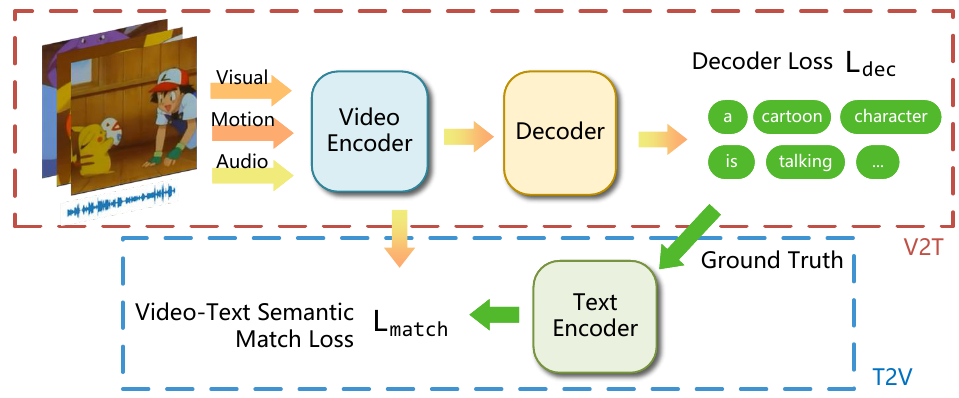
Figure 1. Use of two flows in our method. Traditional video-to-text (V2T) flow: the video encoder encodes the multimodal feature, and the decoder outputs the caption to obtain decoder loss; Text-to- video (T2V) flow: the text encoder encodes the ground-truth caption, and then the model calculates Video–Text Semantic Match